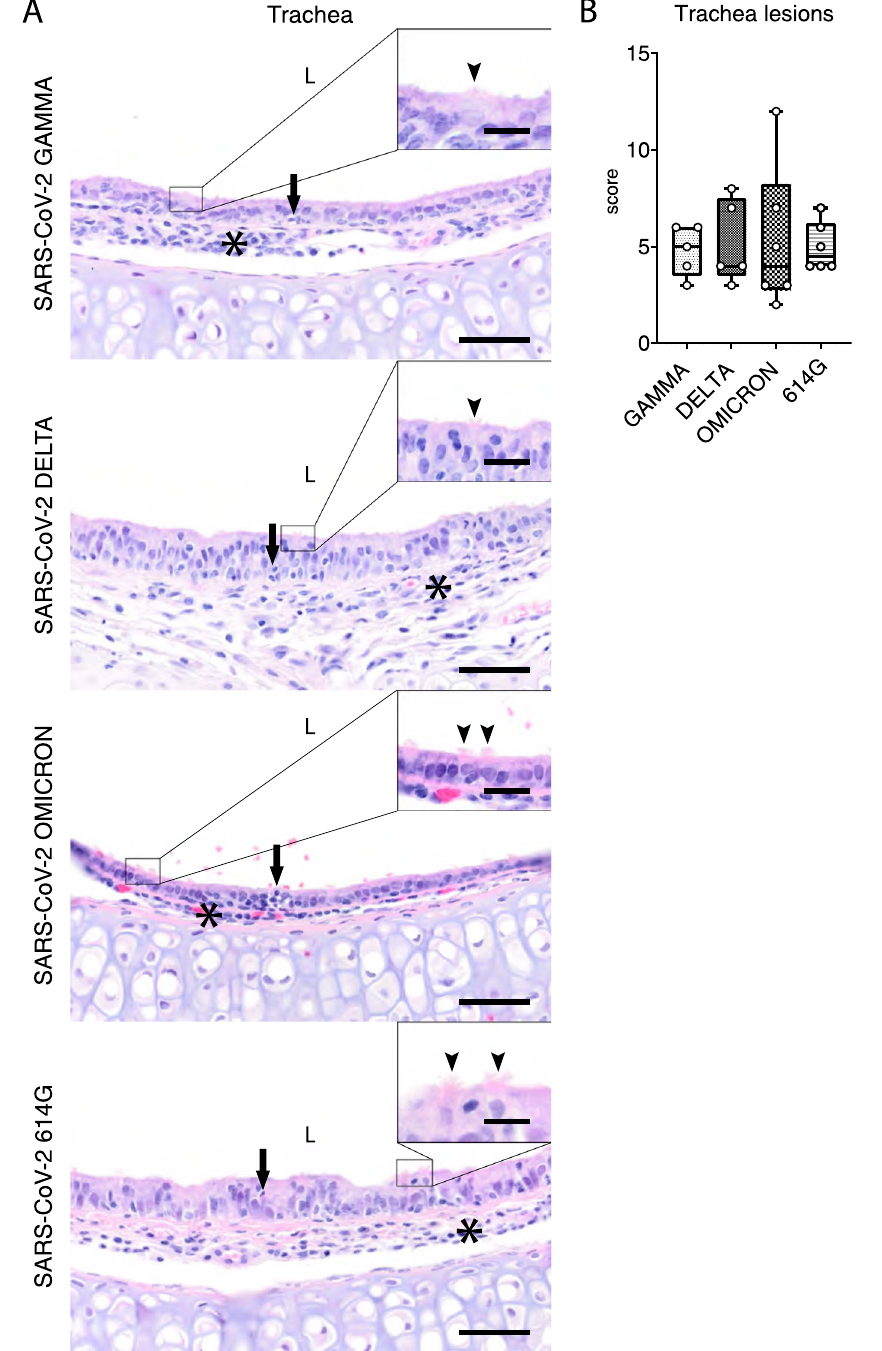
Fig. 4 Tracheal lesions are mild to moderate regardless of the SARS-CoV-2 strain infection in hamsters. A Representative images showing tracheal lesions in hamsters infected with VOCs Gamma, Delta, Omicron or 614 G strain. Trachea histopathological changes were characterized by neutrophilic/ heterophilic exocytosis (arrows) and sub-epithelial in fi ltration of macrophages and neutrophils/heterophils (asterisks). The insets show a higher magni fi cation of the ciliated epithelium. Intact cilia are indicated by arrowheads. In all groups, most cells show ciliary loss. Hematoxylin and eosin stain. Scale bars = 50 µ m and 10 µ m (inset). B Semi-quantitative analysis of tracheal histopathology revealed no statistically signi fi cant differences in the recorded scores among the groups. Data are shown as box and whisker plots. The bounds of the box plot indicate the 25th and 75th percentiles, the bar indicates medians, and the whiskers indicate minima and maxima. Data were tested by two-tailed Mann – Whitney- U tests followed by Benjamini – Hochberg correction. A p -value of ≤ 0.05 was chosen as the cut-off for statistical signi fi cance. N = 5 animals/group for VOCs Gamma and Delta and 6 animals/group for VOC Omicron and 614 G. For quanti fi cations, one entire cross- and one entire longitudinal section were evaluated per animal. Source data are provided as a Source Data fi